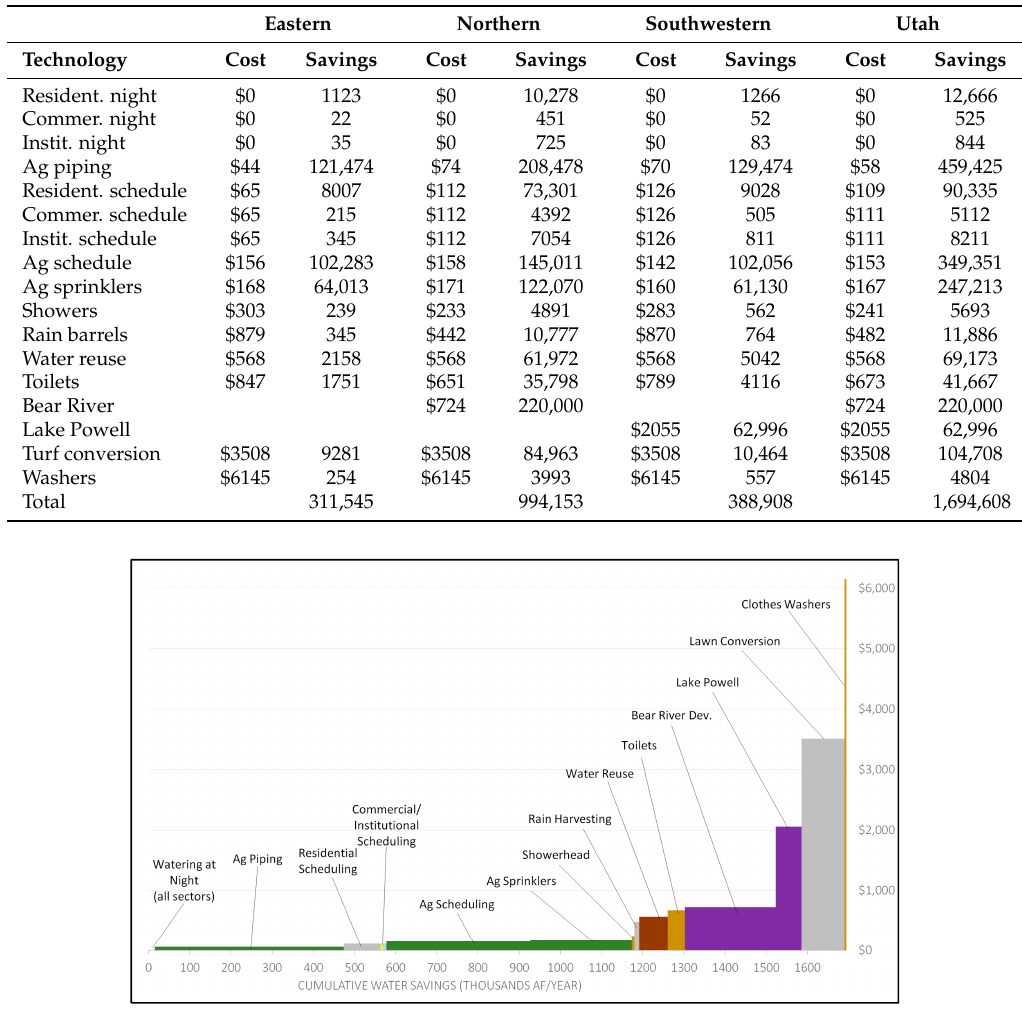
Figure 3. Water efficiency supply curves for Utah.